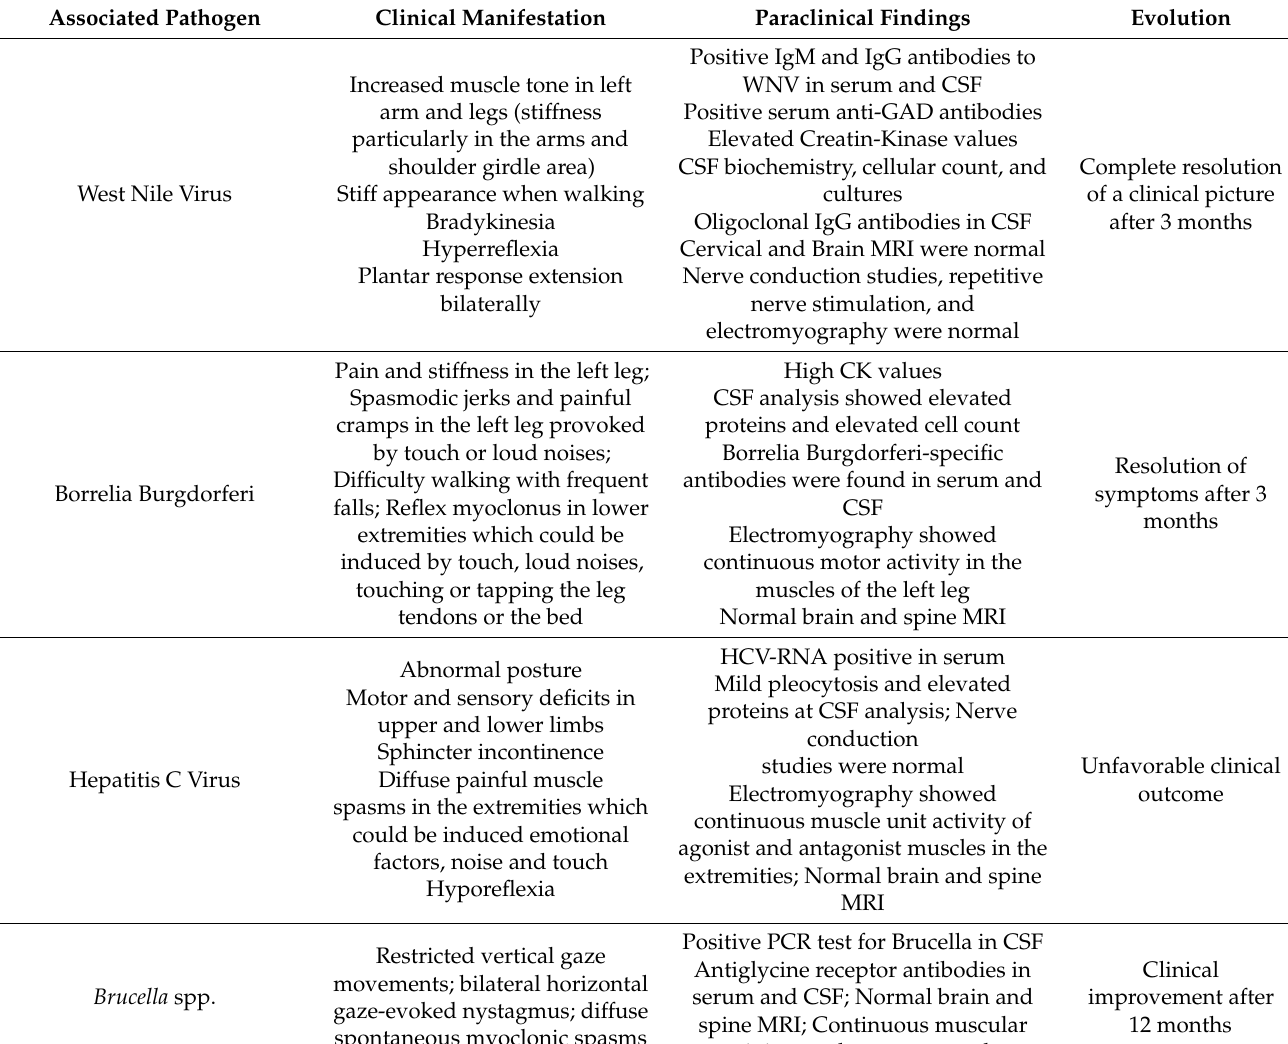
Table 2. Partial stiff-person syndrome linked to specific